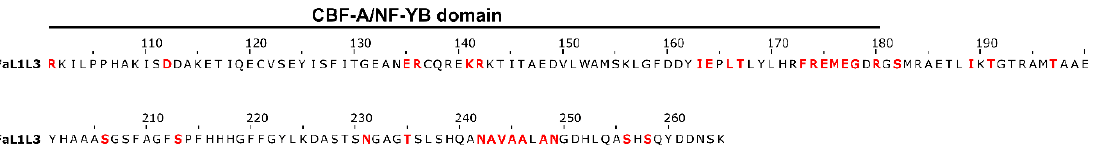
Figure 5. Sites under positive selection in F . × ananassa L1L3 protein used as reference sequence. Red color in letters indicates protein residues subjected to positive selection (Ka/Ks > 1). Ka: non-synonymous site; Ks: synonymous site; L1L: Leafy cotyledon1-like; Fa: Fragaria × ananassa. Additional information can be found in Table